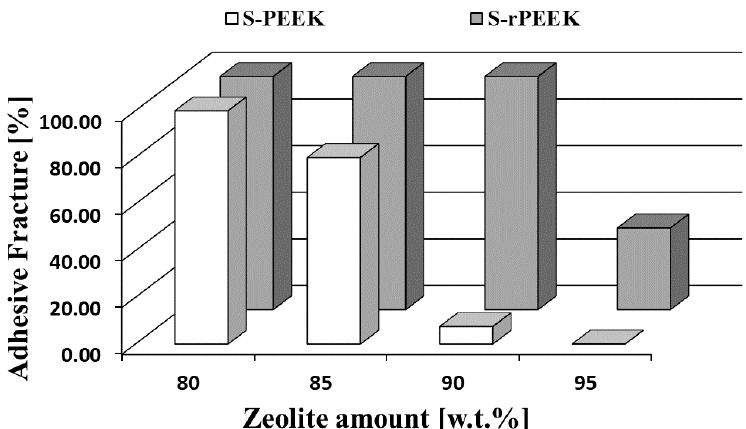
Figure 7. Adhesive fracture mechanism (%) after pull-off test in S-PEEK and S-rPEEK coating at varying filler content.